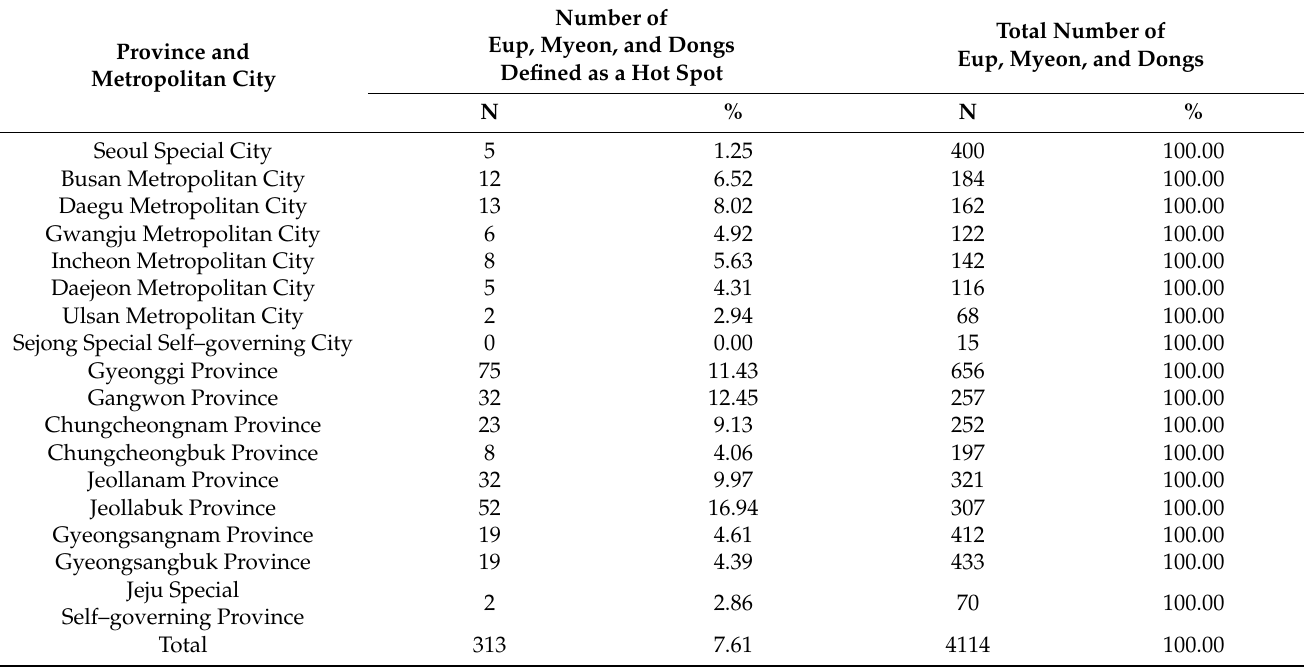
Table 6. Number of Eup, Myeon, and Dongs defined as a hot spot in Province and Metropolitan City.